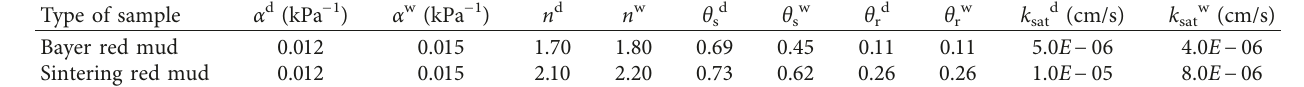
Table 4: Hydraulic characteristic parameters of red mud.